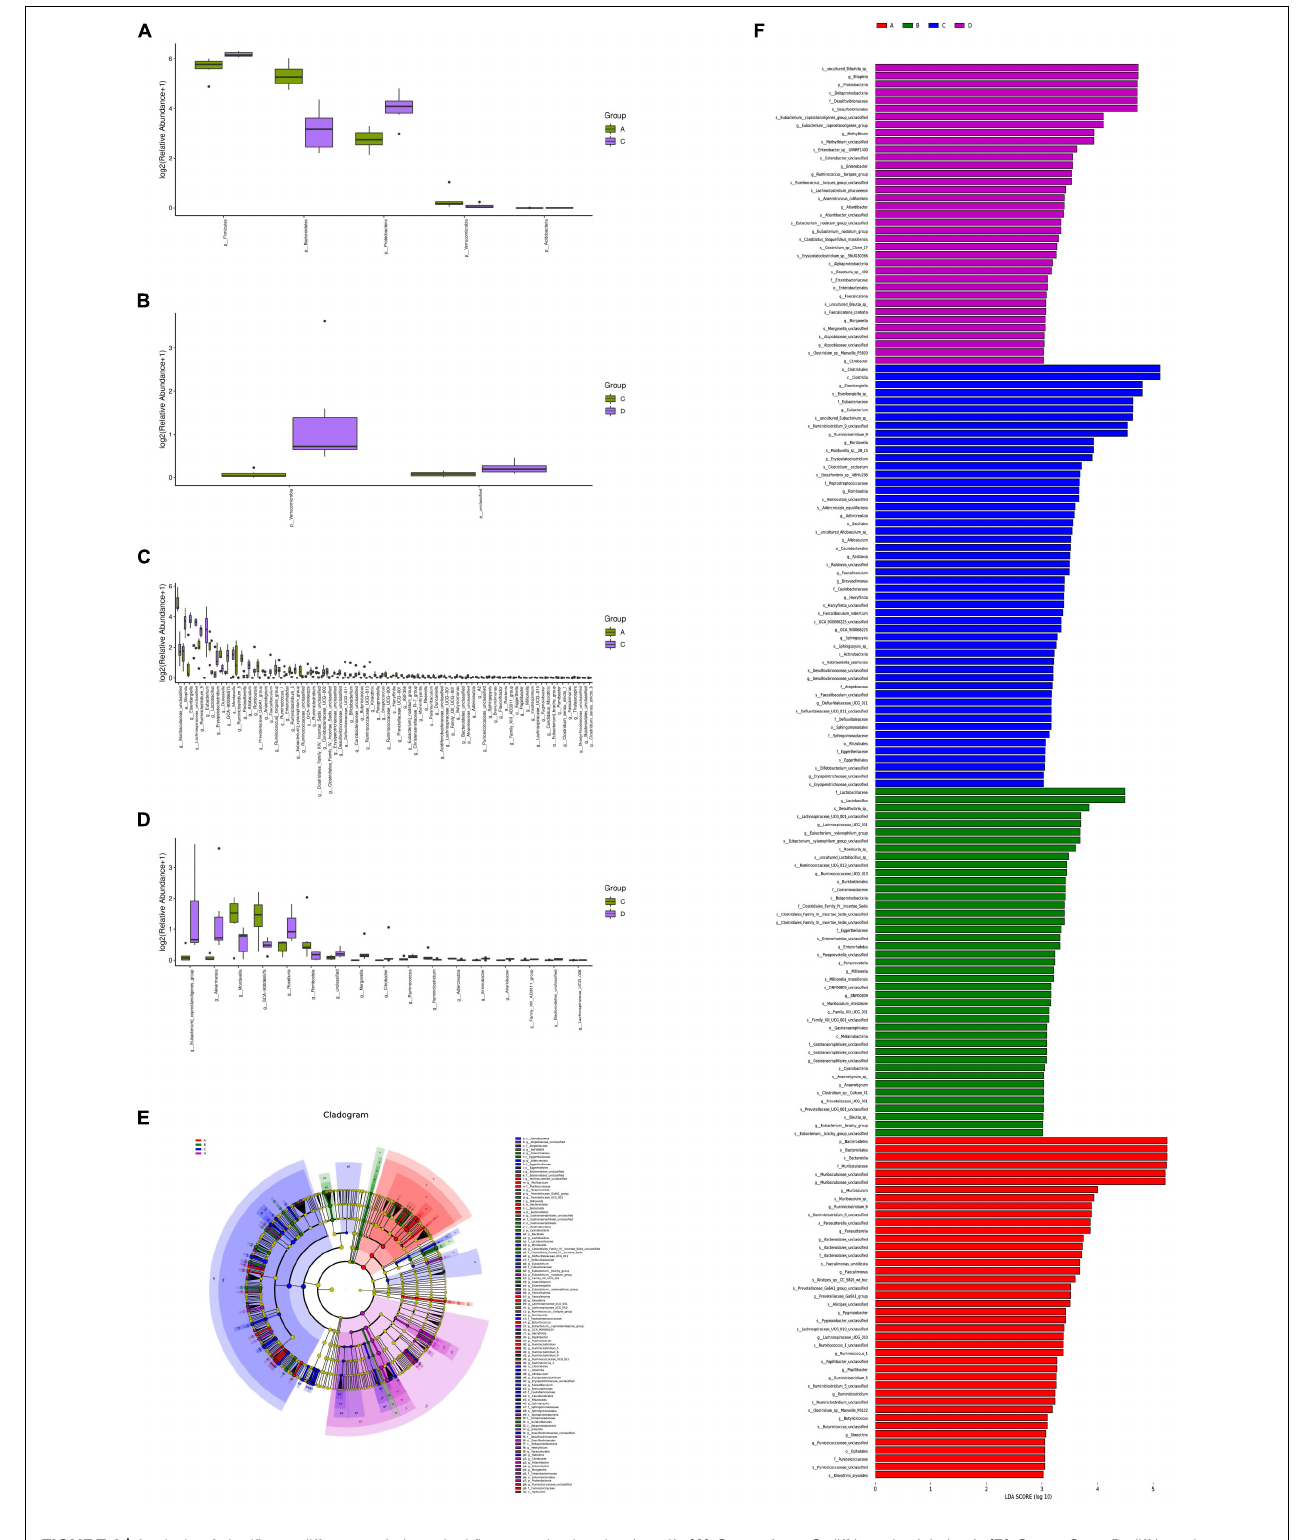
FIGURE 6 | Analysis of significant differences in intestinal flora species in mice ( n = 6). (A) Group A vs. C diff boxplot (phylum). (B) Group C vs. D diff boxplot (phylum). (C) Group A vs. C diff boxplot (genus). (D) Group C vs. D diff boxplot (genus). (E) LEfSe group A vs. B vs. C vs. D cladogram. (F) LEfSe group A vs. B vs. C vs. D. In the figure, A, B, C, and D represent NCD, NCD + MBPs, HFD, and HFD + MBPs, respectively.